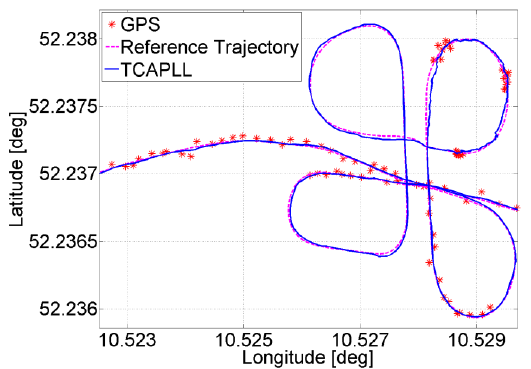
Figure 17. Position solution when three SVs are visible for short periods of time.